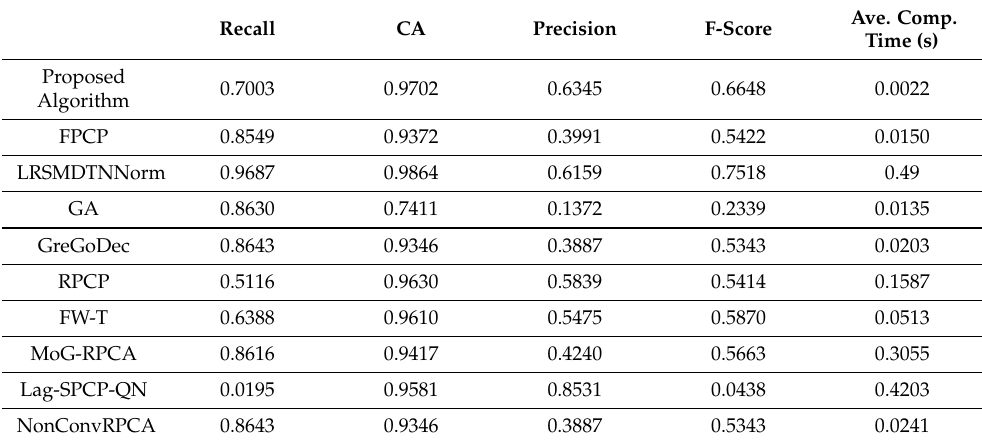
Table 4. Proposed technique foreground segmentation evaluation against different recent algorithms for Video 3.